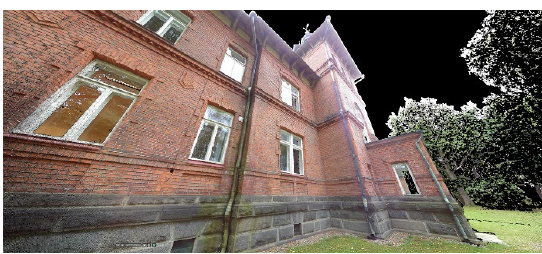
Figure. 1. Outdoor scan station and point cloud data obtained in in the Lielahti mansion campaign, 2016 The data capture campaign in Lielahti mansion supplied the data to conduct the study cases. It included over 100 scan positions indoor and outdoor (Figure 1); and working in a range of resolution between 1 point every 4-10mm at 10